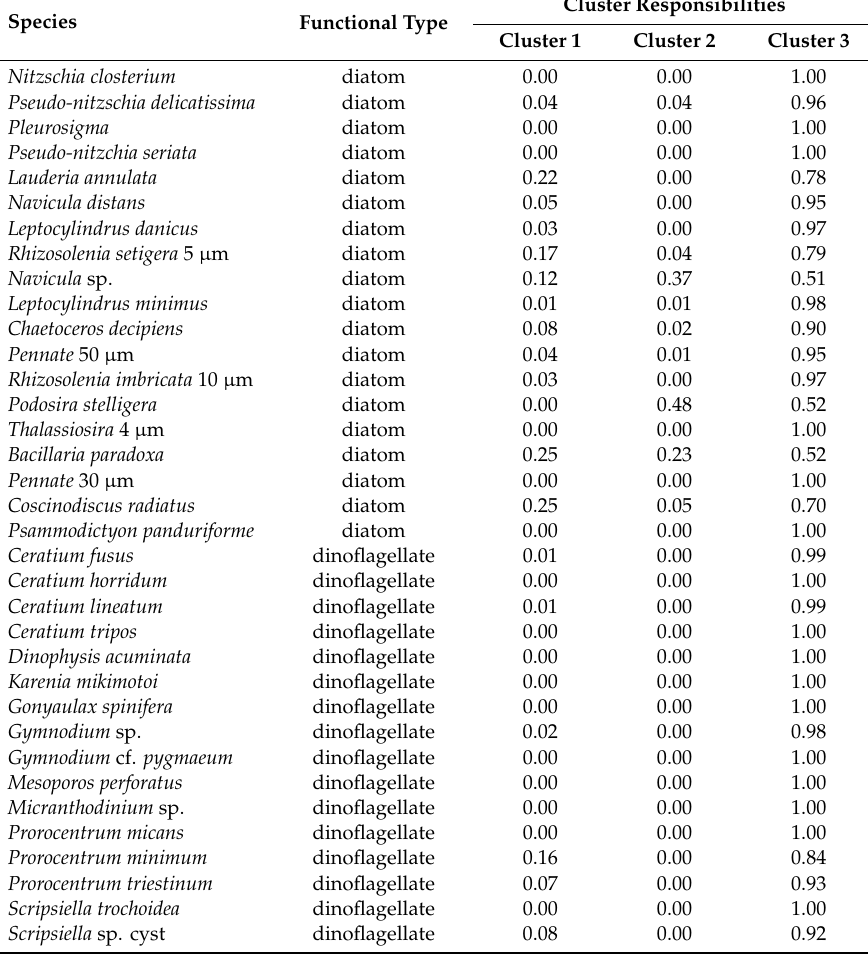
Table A3. List of species assigned to Cluster 3 by the maximum a posteriori clustering solution, their functional types, and their assignment probabilities to the three clusters. This cluster is the largest in terms of the number of species with 35 species and involves all dinoflagellates except Prorocentrum balticum